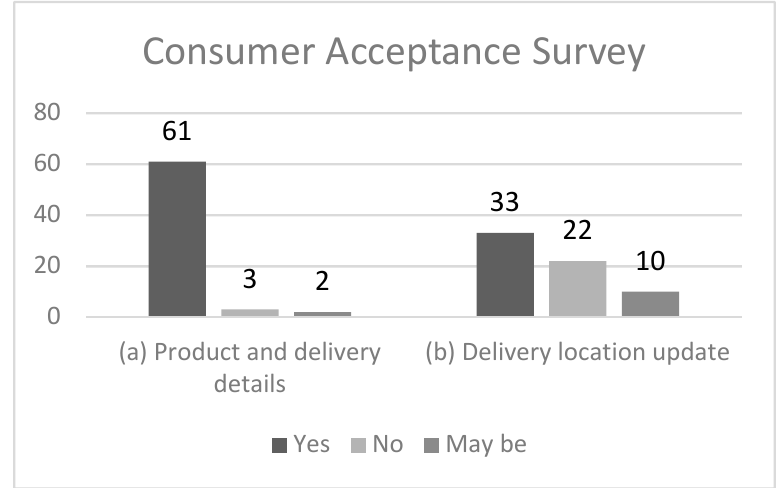
Figure 1. Consumer acceptance survey.